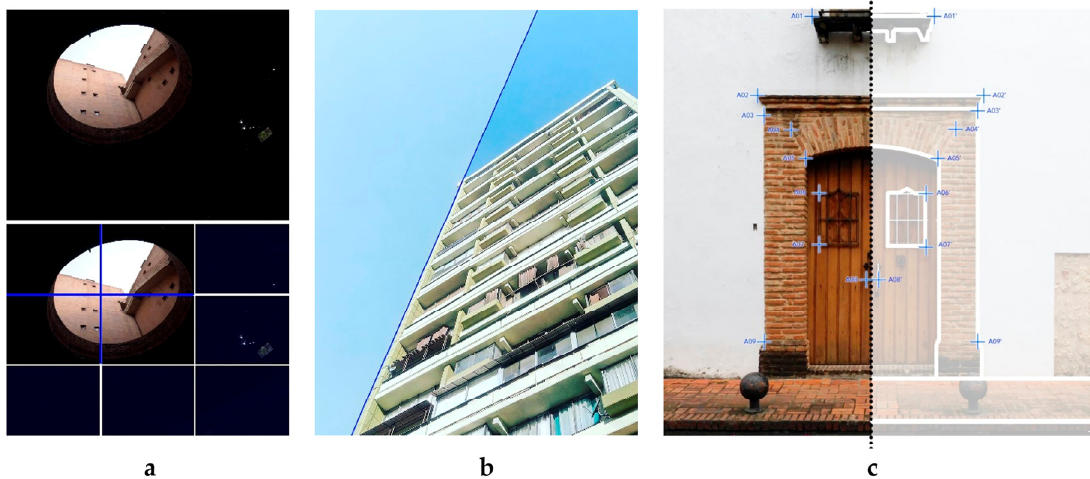
Figure 1. Examples of composition analysis of architectural heritage pictures collected from #patrimonioarquitectonico in Instagram: ( a ) Rule of thirds, the focal point corresponds with the intersection of the blue lines. Font: edited from original (elperrusquinho). ( b ) Dominance diagonal, the blue line clarifies the two areas of the picture which matches one of the vanishing edges. Font: edited from original (jm_ac). ( c ) Symmetry, reference points demonstrate near-perfect vertical symmetry. Font: edited from original (fachadasrd).